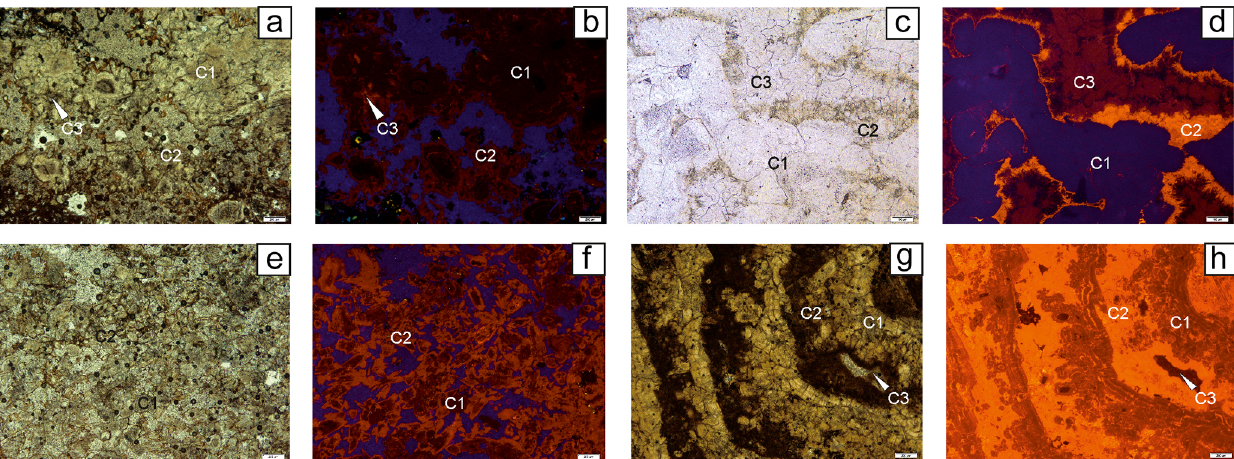
Figure 2. The internal structure of glendonites that are mainly composed of several calcite phases (C1; C2; C3). (a–b) Sample L-1-3, Middle Jurassic (Bajocian–Bathonian), Ludlovskaya-1 well, Barents Sea, Russia, depth 1592 + 6m (authors’ data); (a) under plane-polarized light; the first calcite phase represents rosette-like crystals showing distinct core; (b) the same thin section under CL. (c–d) Sample RM2019-27, lower Neogene (lower Miocene), eastern coast of Sakhalin Island, Russia (authors’ data); (c) under plane-polarized light; (d) the same thin section under CL. (e–f) Sample Led-1-3, Middle Jurassic (Bajocian–Bathonian), Ledovaya-1 well, Barents Sea, Russia, depth 1824 + 6.6m (authors’ data); (e) elongated calcite crystals (C1), surrounded by the second calcite phase (C2), sample Led-1-3 under plane-polarized light; (f) the same thin section under CL. (g–h) Sample F3-1-1, Lower Cretaceous (upper Hauterivian), Festningen, Svalbard (authors’ data); (g) microzoning glendonite under plane-polarized light; the first calcite phase is distinguished zoning as well; (h) the same thin section under